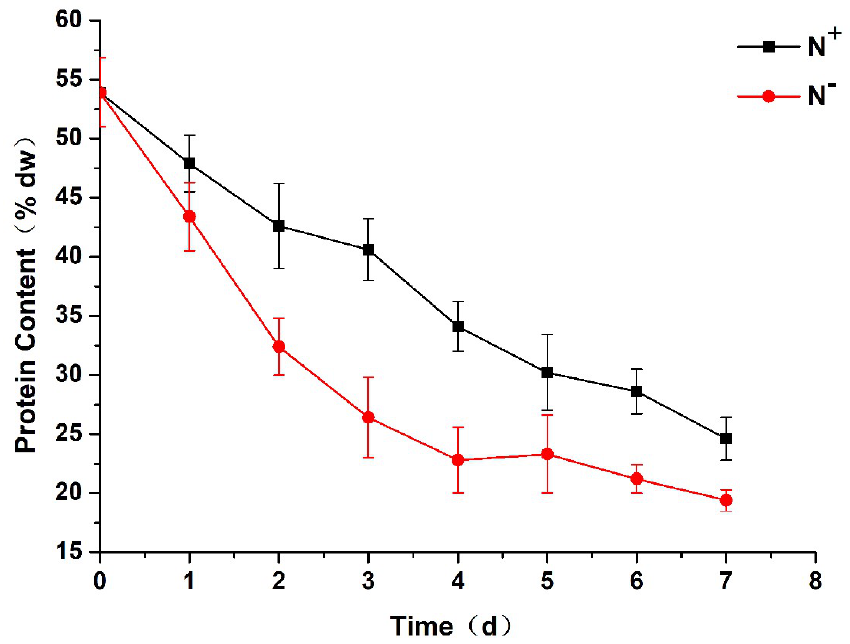
Figure 8. Comparison of total protein content of Parachlorella kessleri TY02 under N + and N − culture media. Data are shown as mean ± SE. n = 3.